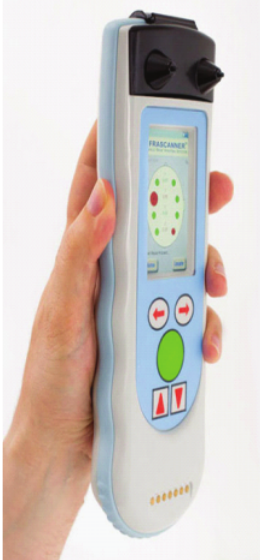
Figure 2: The infrascanner intracranial haematoma detector, model 2000. Courtesy of Infrascan Handheld brain